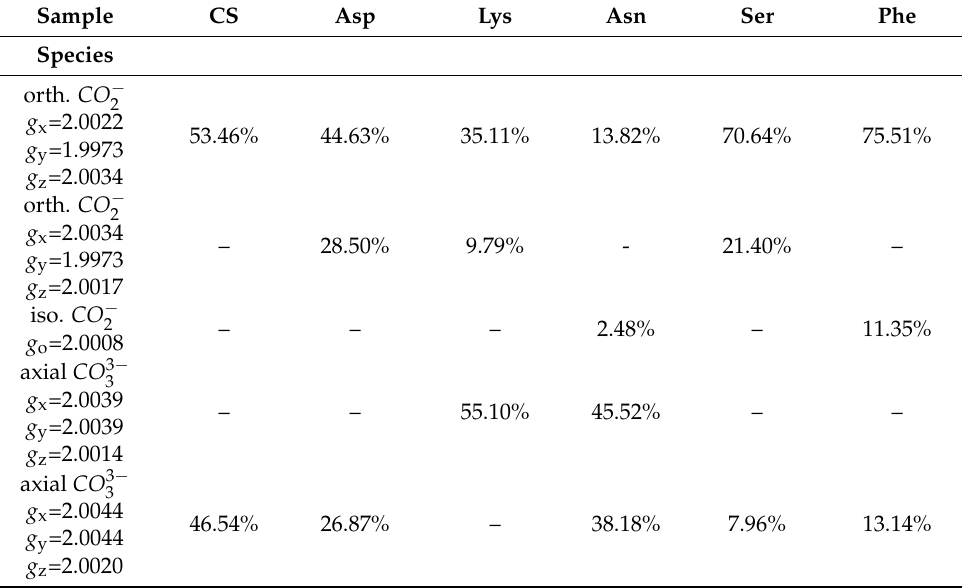
Table 4. Radical species identified in the EPR spectra of samples with extracted EPR parameters and weight based on spectra simulation. Asp—aspartic acid, Lys—lysine, Asn—asparagine, Ser—serine,